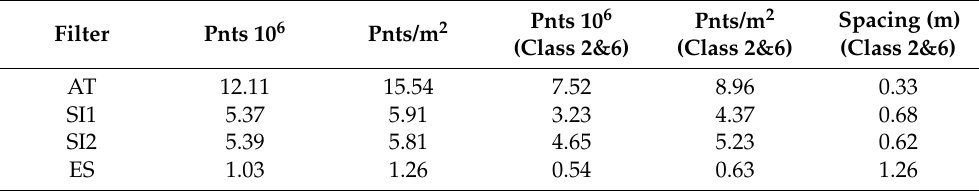
Table 1. Data point density for test sites. Pnts 10 6 : No. of all data points in millions; Pnts/m 2 : median point density per m 2 (average density is in this case equal to Pnts 10 6 ); Pnts 10 6 class 2&6: No. of points used for interpolation (ASPRS classes 2 and 6); Pnts/m 2 : median density of points used for interpolation per m 2 (ASPRS classes 2 and 6); Spacing: average spacing between the points used for interpolation (ASPRS classes 2 and 6).